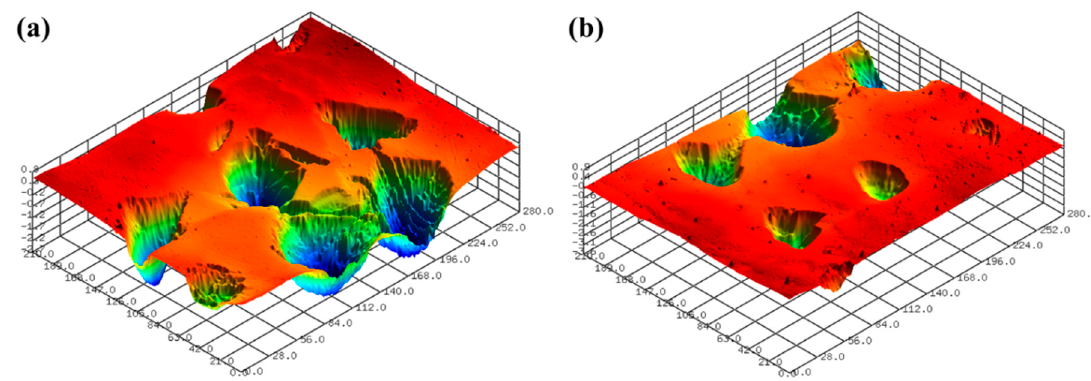
Figure 5. Representative surface profiles of SLA 3D-printed ABS-like resin after CMP for 150 min; ( a ) Sa of 0.490 μ m and Sz of 3.805 μ m ( b ) Sa of 0.393 μ m and Sz of 3.755 μ m.